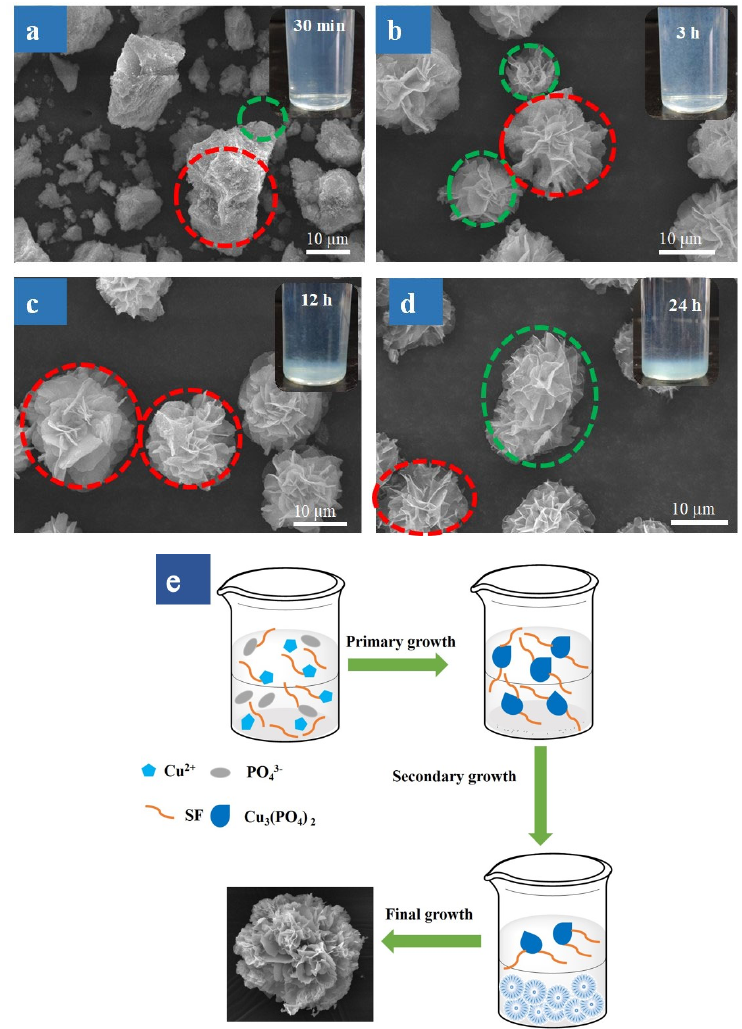
Figure 3. ( a – d ) SEM images of the nanostructures of SF@Cu ‐ NFs products at different preparation times of 30 min, 3 h, 12 h, and 24 h. Insets are photographies of solution change. ( e ) Schematic illustration of the formation process of SF@Cu ‐ NFs products at preparation time of 12 h.